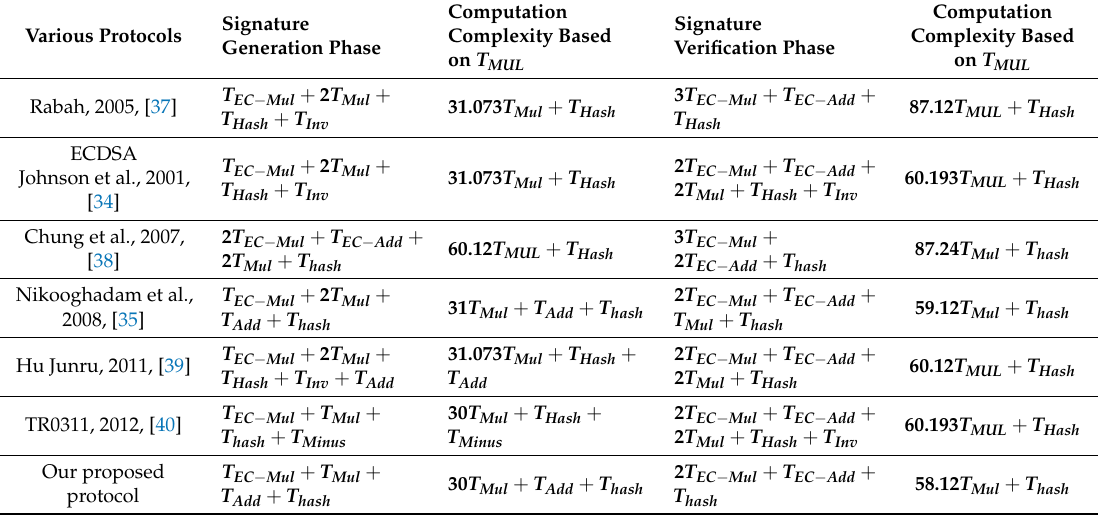
Table 2. Comparing various protocols in term of time complexity.